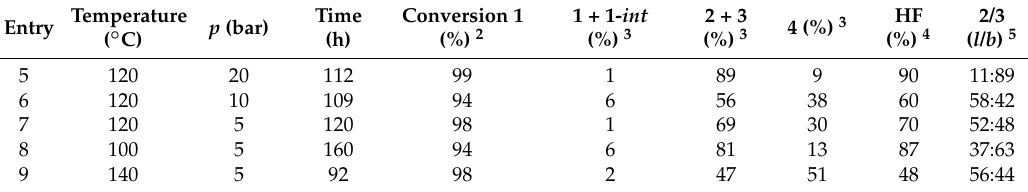
Table 2. Variation of temperature and pressure in the tandem isomerization–hydroformylation of oleonitrile by the Rh(acac)(CO) 2 –Biphephos system in toluene (A reaction conducted in MeCN at [ 1 ] 0 /[Rh] = 200, [Biphephos]/[Rh] = 2, [ 1 ] 0 = 0.1 mol L − 1 , T = 120 ◦ C, p = 5 bar CO/H 2 (1:1) over 91 h afforded 100% conversion ( 1 + 1- int < 0.1 mol %), 70 mol % of 2 + 3 with l/b = 42:58, and 30 mol % of 4 (HF = 81%); compare with entry 7). 1